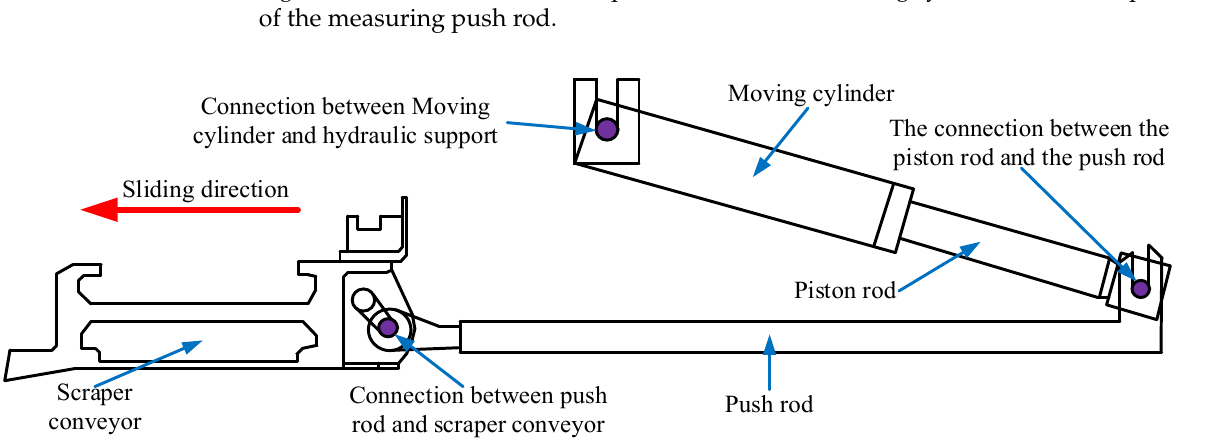
hydraulic support.